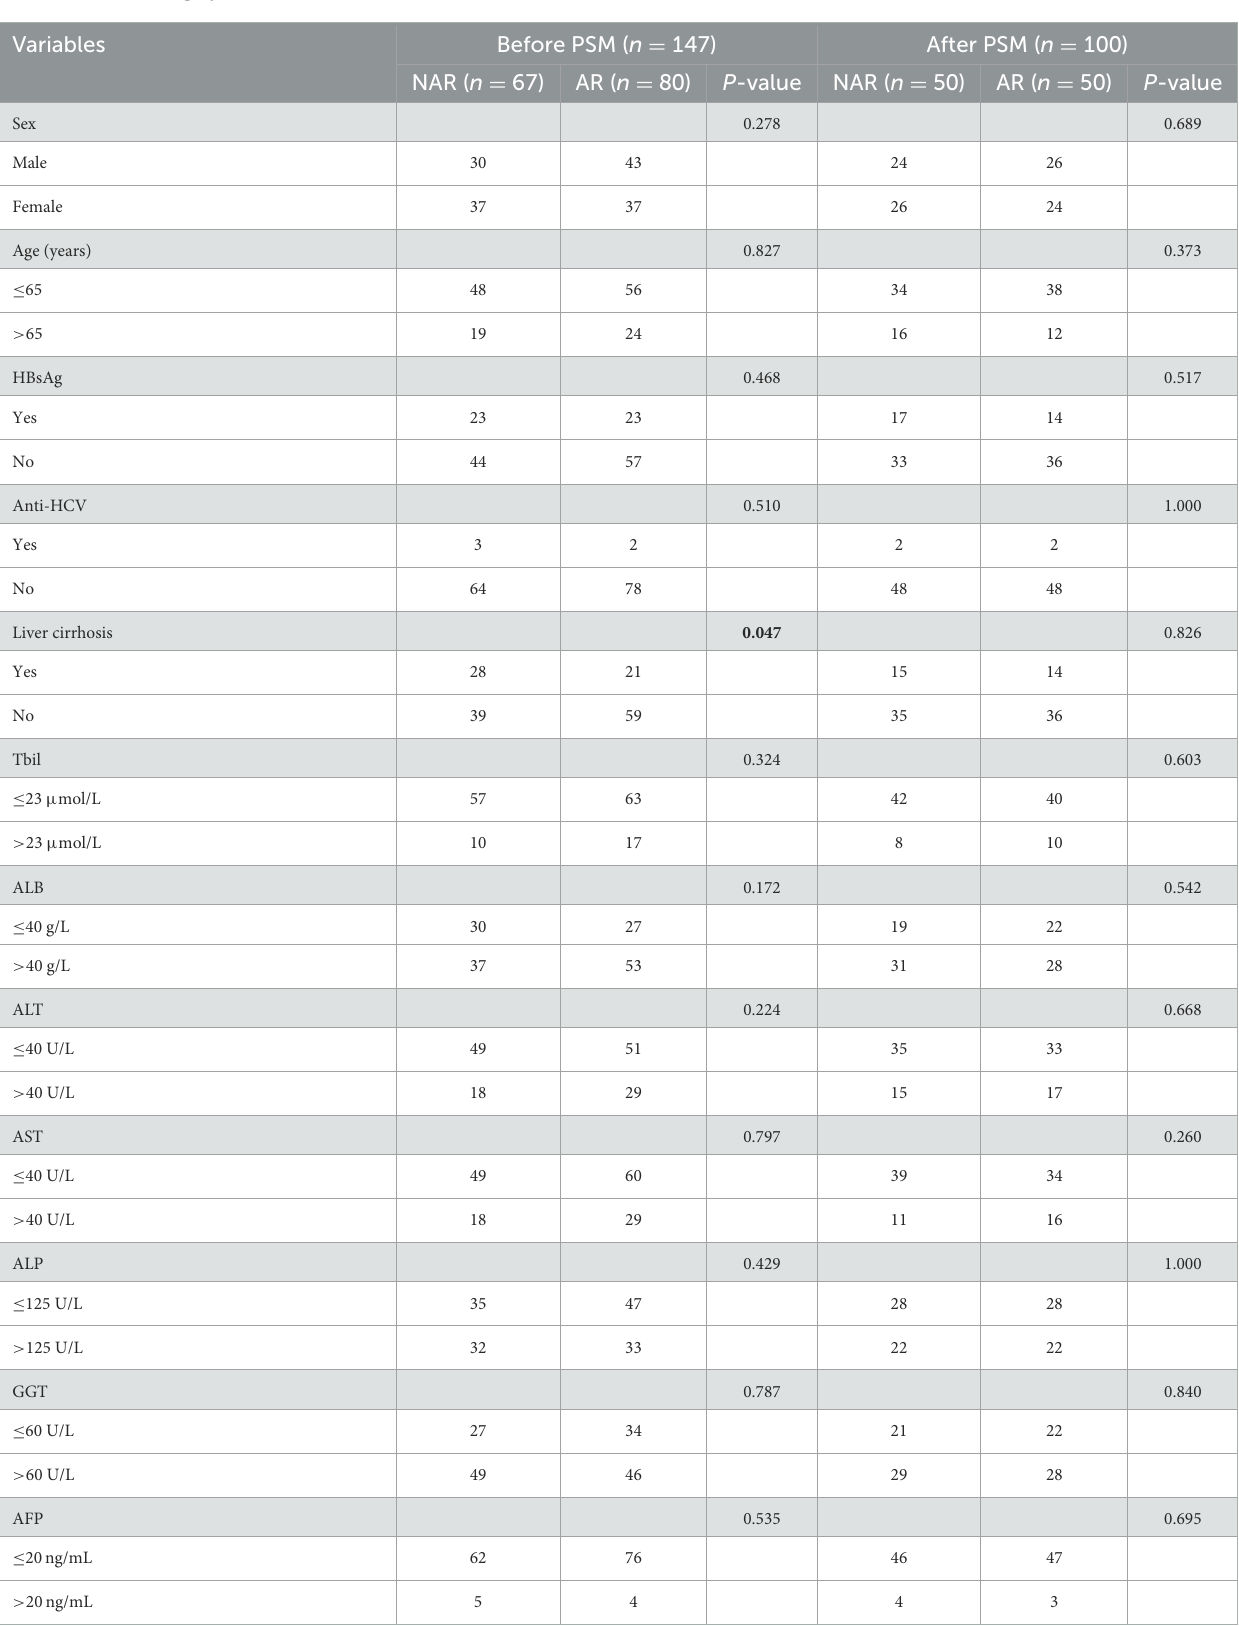
TABLE 1 Patient demographics and tumor